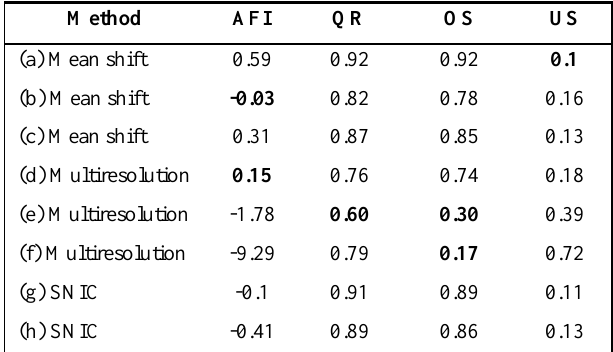
Table 2 . Segmentation assessment metrics: Area Fit Index (AFI), Quality Rate (QR), Oversegmentation (OS), and Undersegmentation (US). The best results are highlighted (with zero being the ideal value. (a) Mean shift: range radius = 5, minimum region size = 20; (b) Mean shift: range radius = 5, minimum region size = 60; (c) Mean shift: range radius =